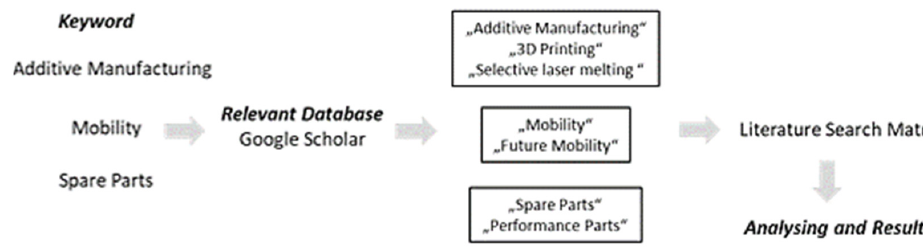
Figure 3. Systematic literature search.